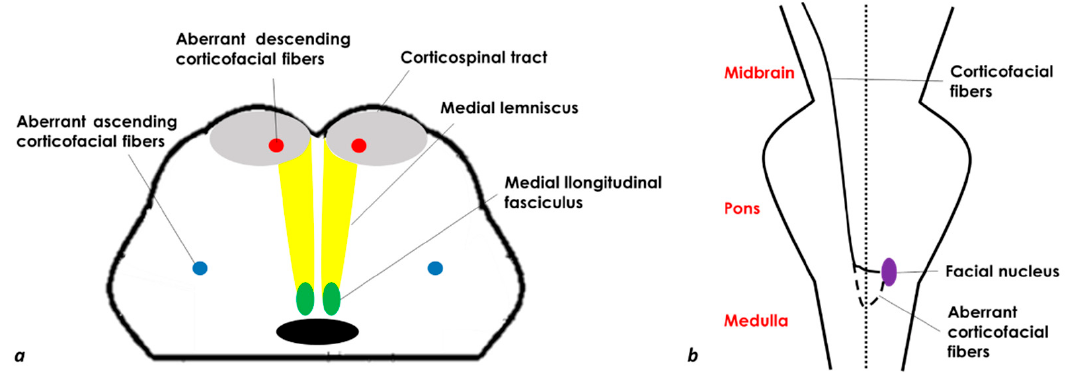
Figure 3. Schematic drawing of a medulla axial section (a) and a coronal section of the brainstem with the aberrant corticofacial fibers (b) (modified and redesigned from [19]).